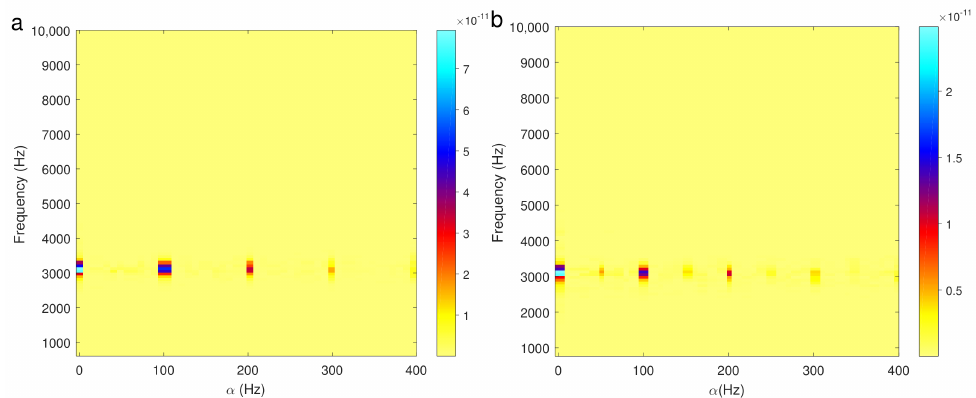
Figure 10. The MID SCor ∆ of the decomposed BLIMF2 using VMD ( a ) and IMF3 using EMD ( b ). f